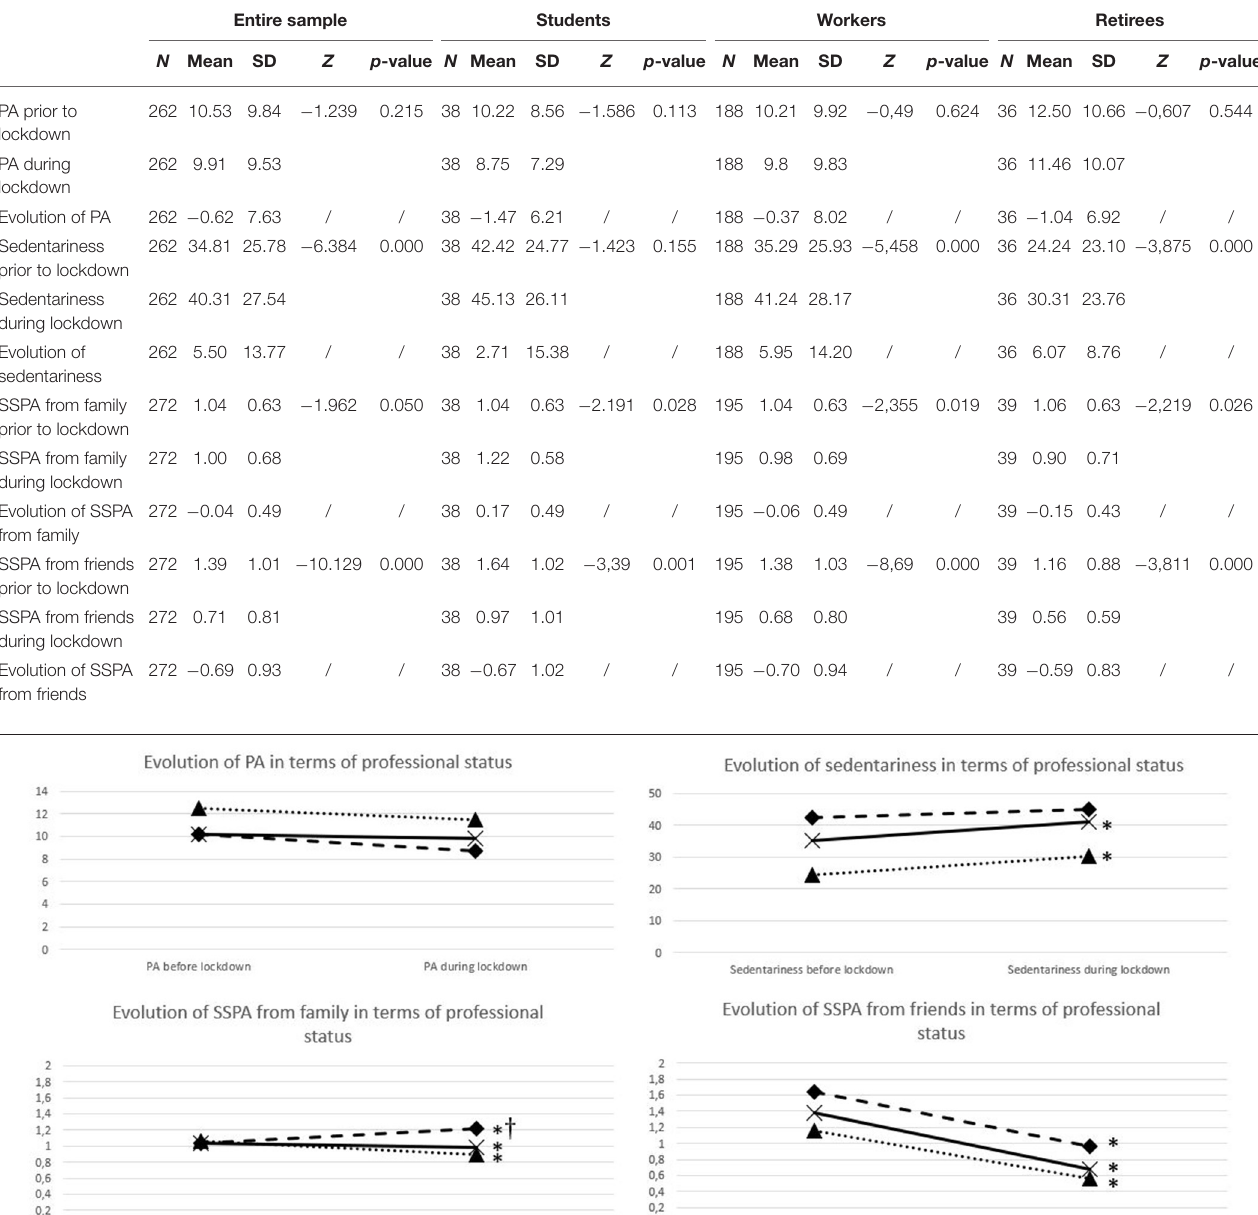
TABLE 2 | Descriptive statistics and evolutions over time.